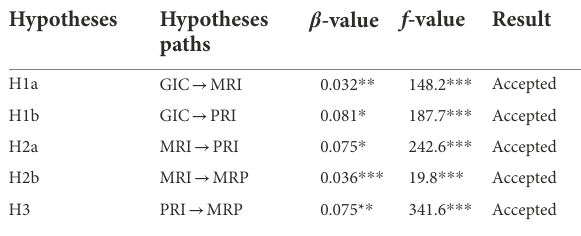
TABLE 4 The structural